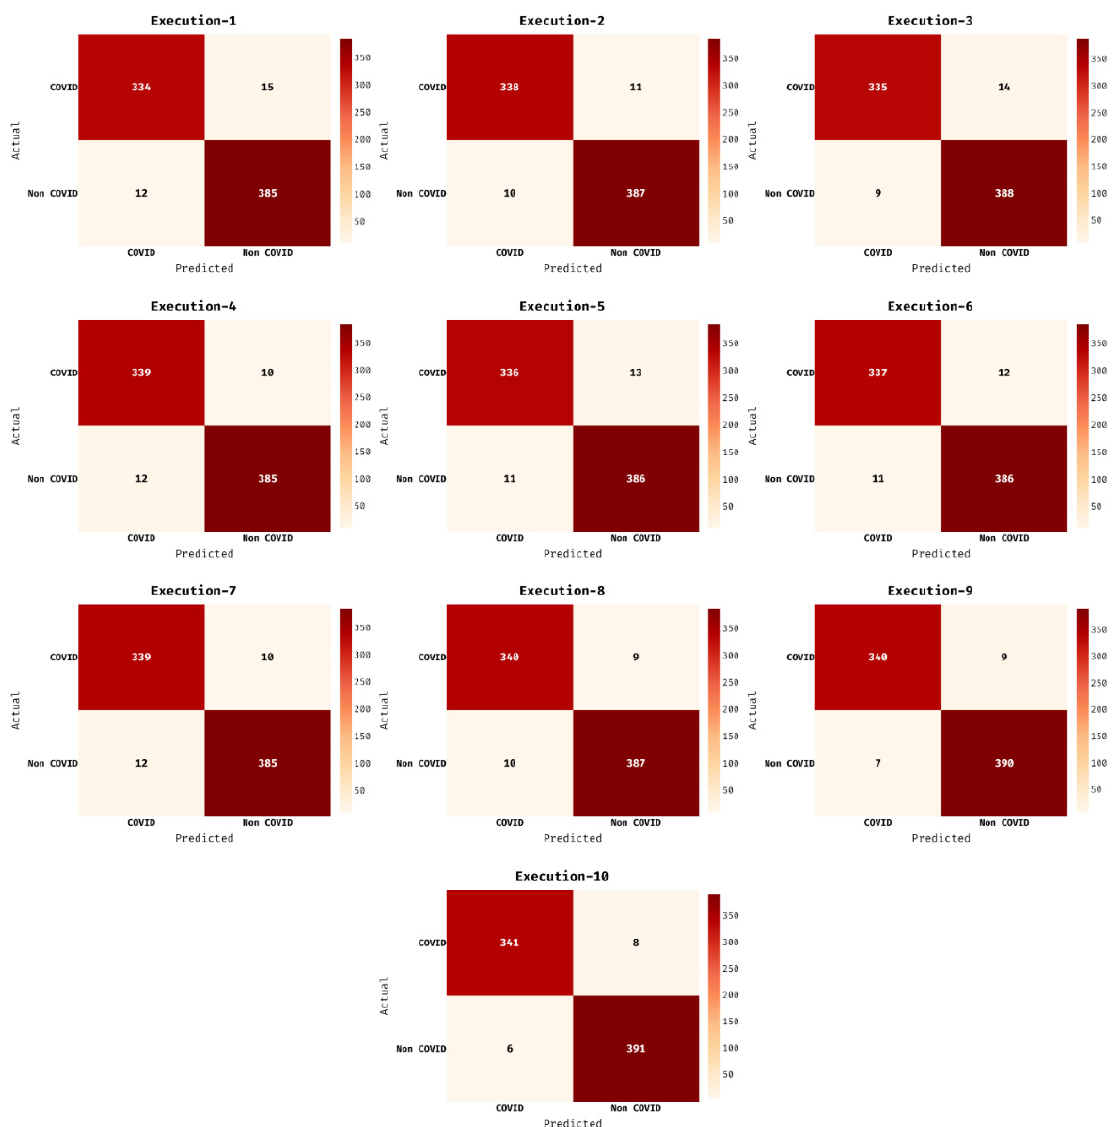
Figure 4. Confusion matrix of AIEM-DC technique under ten executions.